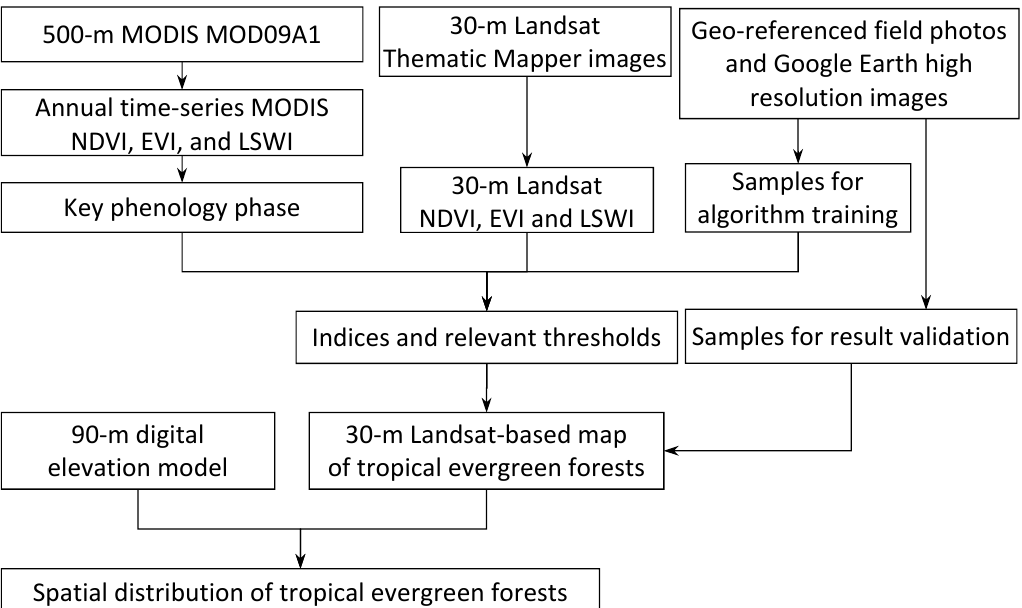
Figure 2. The technique workflow for mapping tropical evergreen forests. (1) A key phenology phase is selected based on analysis of annual time-series 500-m Moderate Resolution Imaging Spectroradiometer (MODIS) MOD09A1 Normalized Difference Vegetation Index (NDVI), Enhanced Vegetation Index (EVI), and Land Surface Water Index (LSWI) for different land cover types; (2) 30-m Landsat NDVI, EVI, and LSWI in the key phenology phase are evaluated to find an optimal combination of them for distinguishing tropical evergreen forests from other land cover types based on samples extracting from geo-referenced field photos and Google Earth high resolution images of the study area; (3) Based on (2), a 30-m map of tropic evergreen forests is generated based on Landsat Thematic Mapper (TM) imagery and verified by a confusion matrix built from samples created by the same method used above; (4) Spatial distribution of tropical evergreen forests is analyzed base on a 90-m digital elevation model.